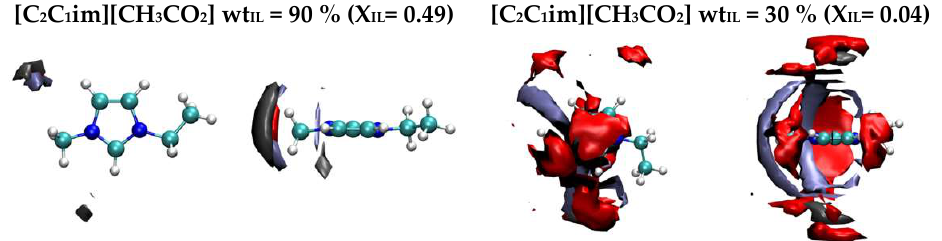
Figure 12. Selected spatial distribution functions around the [C 2 C 1 im] + cation in aqueous mixtures of [C 2 C 1 im][C n F 2 n +1 SO 3 ], [C 2 C 1 im][C n H 2 n +1 SO 3 ], [C 2 C 1 im][CF 3 CO 2 ], and [C 2 C 1 im][CH 3 CO 2 ] at 300 K. The grey, red, and green colors represent C, O (-CO 2 )/S (-SO 3 ) and F atoms of anion, respectively, and light blue depicts water O atom. The isosurface value is 70% of the maximum number density.